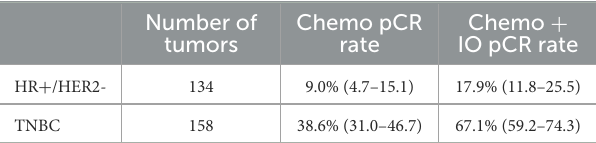
TABLE 4 Virtual clinical trial results using the Virtual TumorBank . Known pCR rates from chemotherapy alone vs. predicted pCR rates from chemotherapy plus pembrolizumab therapy, demonstrating an increase in response produced by